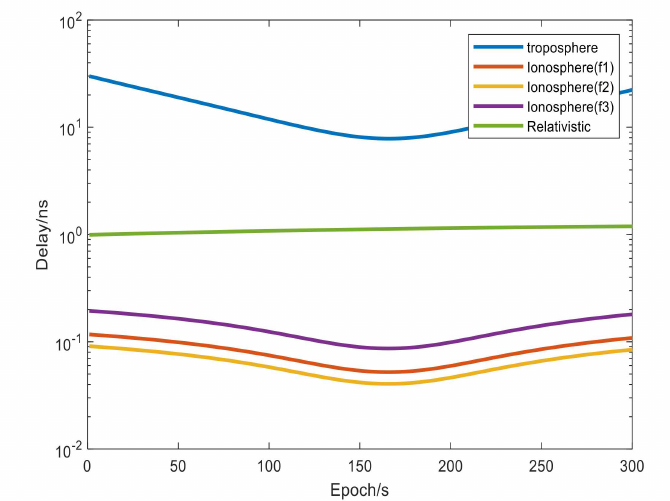
Figure 5. Contribution of atmospheric and relativistic delays in the simulated pseudorange of the f1/f2/f3 signal (absolute values).